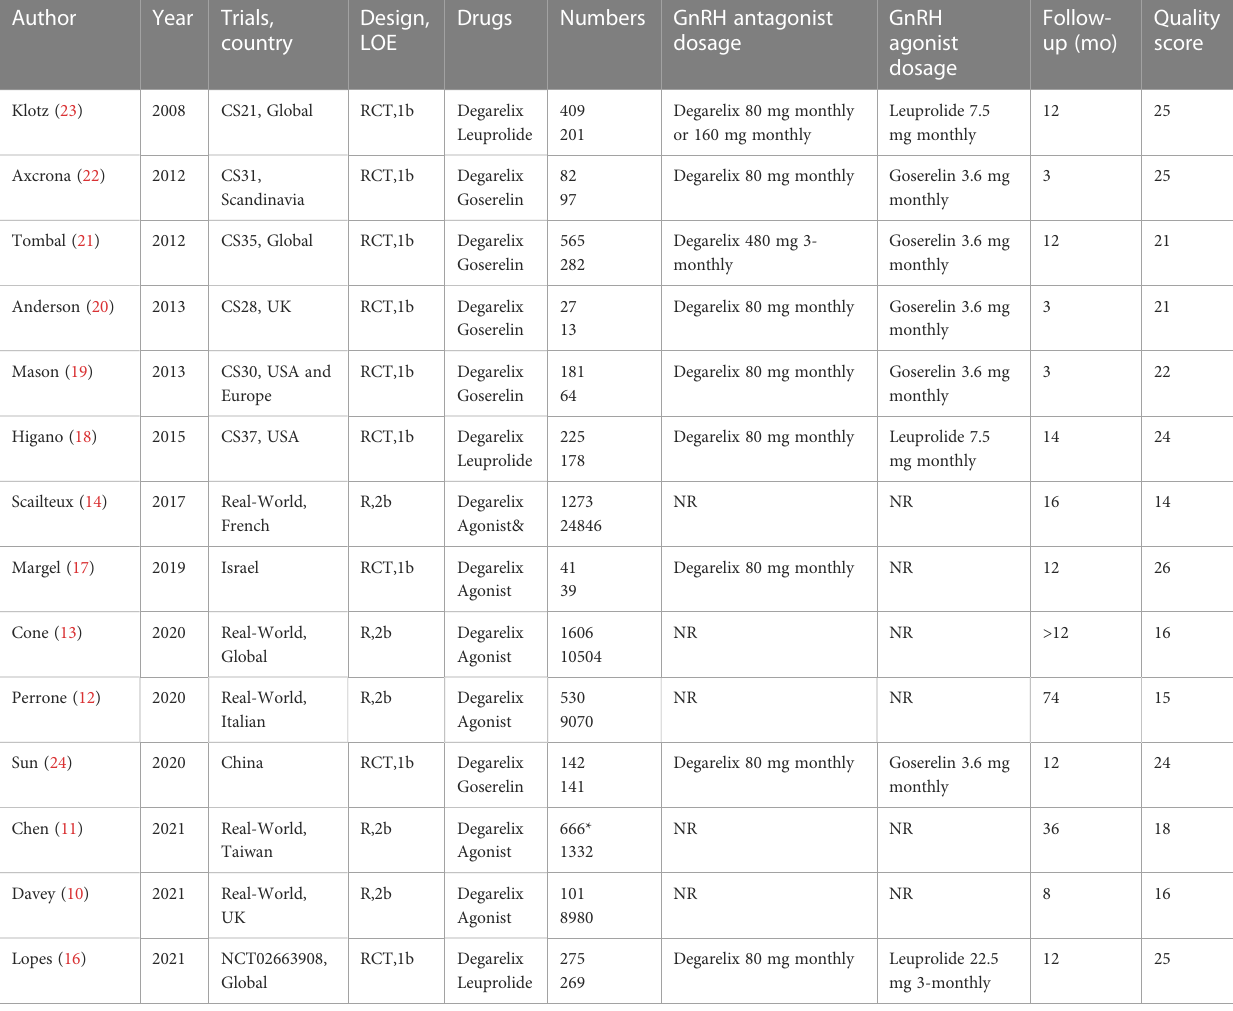
LOE, level of evidence; R, retrospective. Agonist& means usage of one of leuprolide, goserelin, triptorelin or histrelin. RCT, randomized controlled trial; NR, none reported. * Propensity Score Matched from 708 and 10619 patients treated with Degarelix and on time of follow-up (>12 months or <12 months) was performed (Figure 2D). The results showed that GnRH antagonist recipients experienced less CV even during either the short-term (RR: 0.53, 95% CI: 0.38-0.74, P<0.001, I 2 = 17%) or the relatively long-term follow-up period (RR: 0.72, 95% CI: 0.63-0.83, P<0.001, I 2 = 62%). Nine studies comprising 2473 GnRH antagonist and 2477 GnRH agonist recipients reported CV death, among which 23 (0.9%) and 50 (2%) CV deaths occurred, respectively. The RR of CV death for GnRH antagonists as compared with GnRH agonists was 0.4 (95% CI: 0.24-0.67, P<0.001, I 2 = 0%, Figure 3A). The subgroup analysis also showed signi fi cantly fewer CV deaths among GnRH antagonist recipients in RCTs (Figure 3A, RR: 0.46, 95% CI: 0.26-0.81, P=0.007, I 2 = 0%) and real-world data (Figure 3A, RR: 0.21,95% CI: 0.06-0.70, P=0.01).